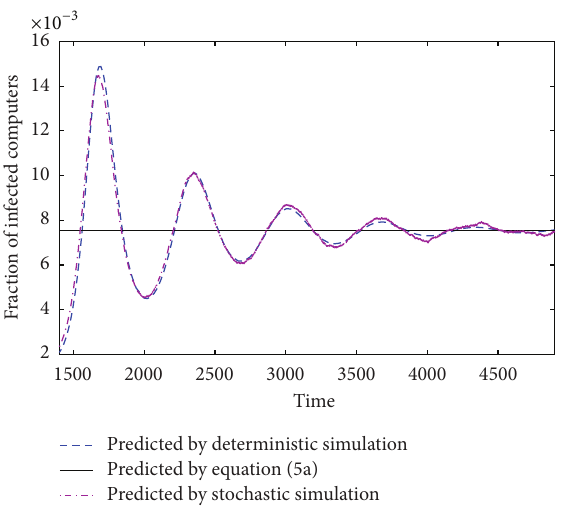
Figure 2: Fraction of infected computers when 𝑅 0 < 1 . (a) Blue (dash line): deterministic simulation; (b) black (solid line): theoretical value; (c) purple (dot-dash line): stochastic